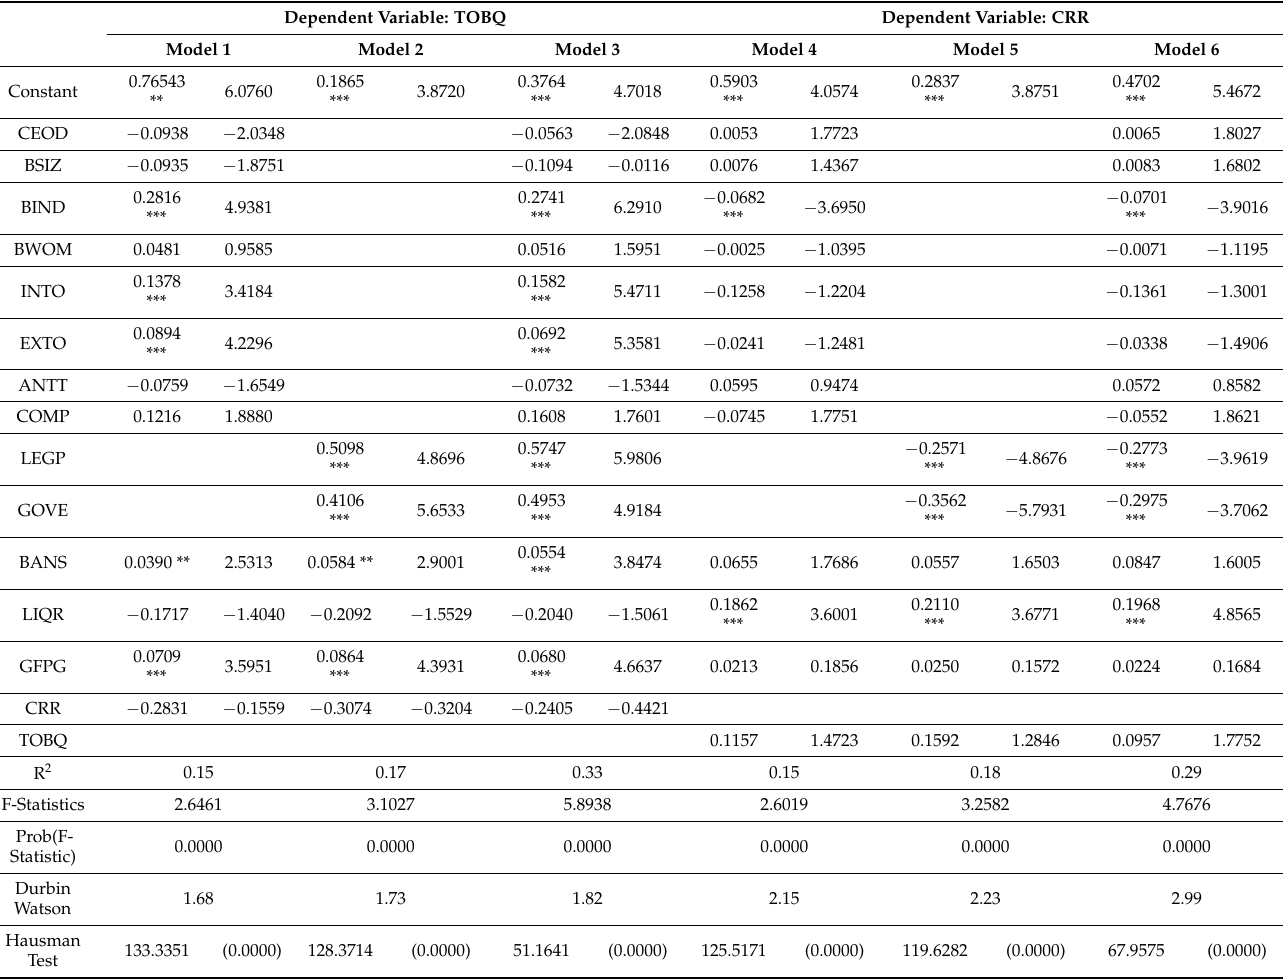
Table 7. Regression Analysis—Fixed Effects